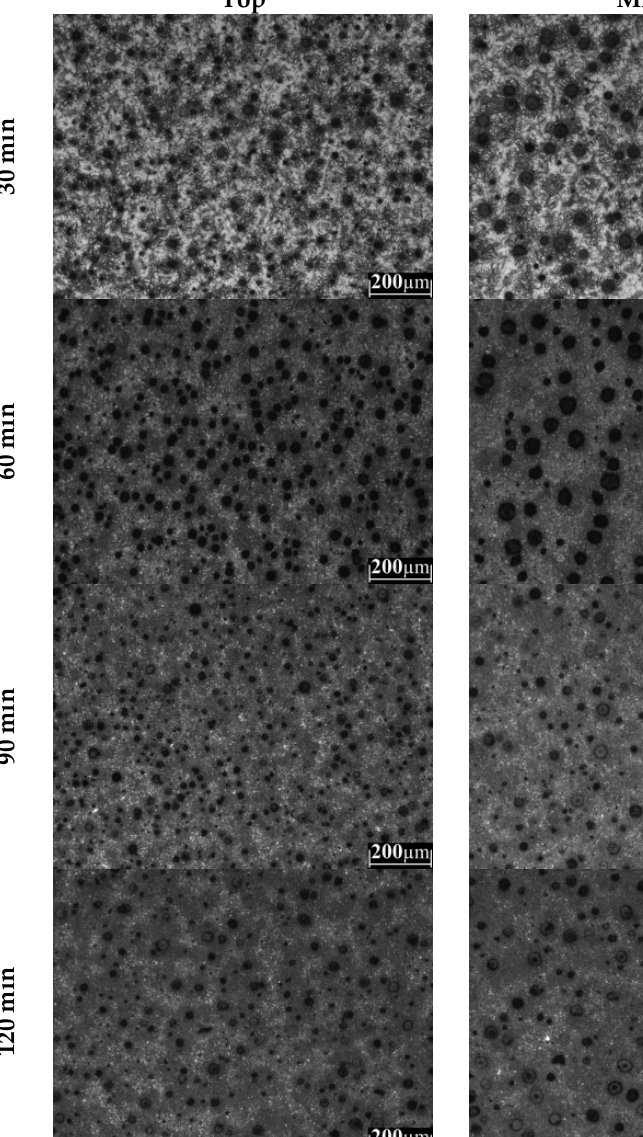
Figure 5. Microstructural evolution for the ADI ‐ 0.2V ‐ 265 sample at the austempering times of 30, 60, 90, and 120 min. Top Middle Bottom